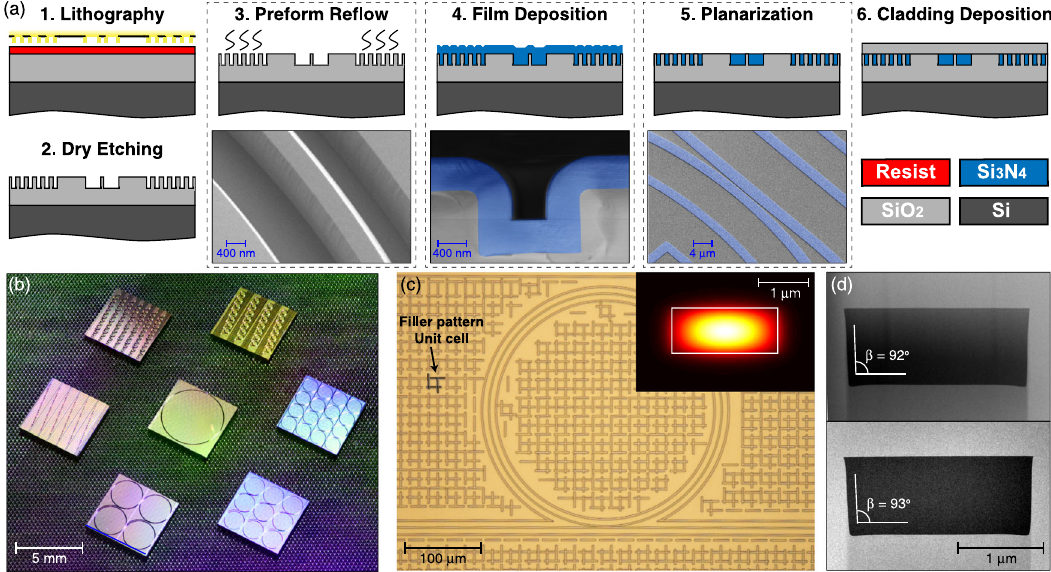
Fig. 2 The wafer-scale photonic Damascene process fl ow and highlighted features. a Process fl ow of the optimized photonic Damascene process including DUV stepper lithography, preform dry etching, preform re fl ow, LPCVD Si 3 N 4 deposition, planarization, and SiO 2 cladding deposition. The blue shaded parts are Si 3 N 4 . b Photograph showing Si 3 N 4 photonic chips with microring resonators of different FSRs. c Optical micrograph showing the bus waveguide, microring resonator, and fi ller patterns (used to prevent crack formation). Inset: simulated tightly con fi ned optical mode. d Transmission electron micrographs (TEM) of the waveguide cross-sections, before (top) and after (bottom) the preform re fl ow. The re fl ow preserves the waveguide dimensions accurately, while removing high-frequency spatial